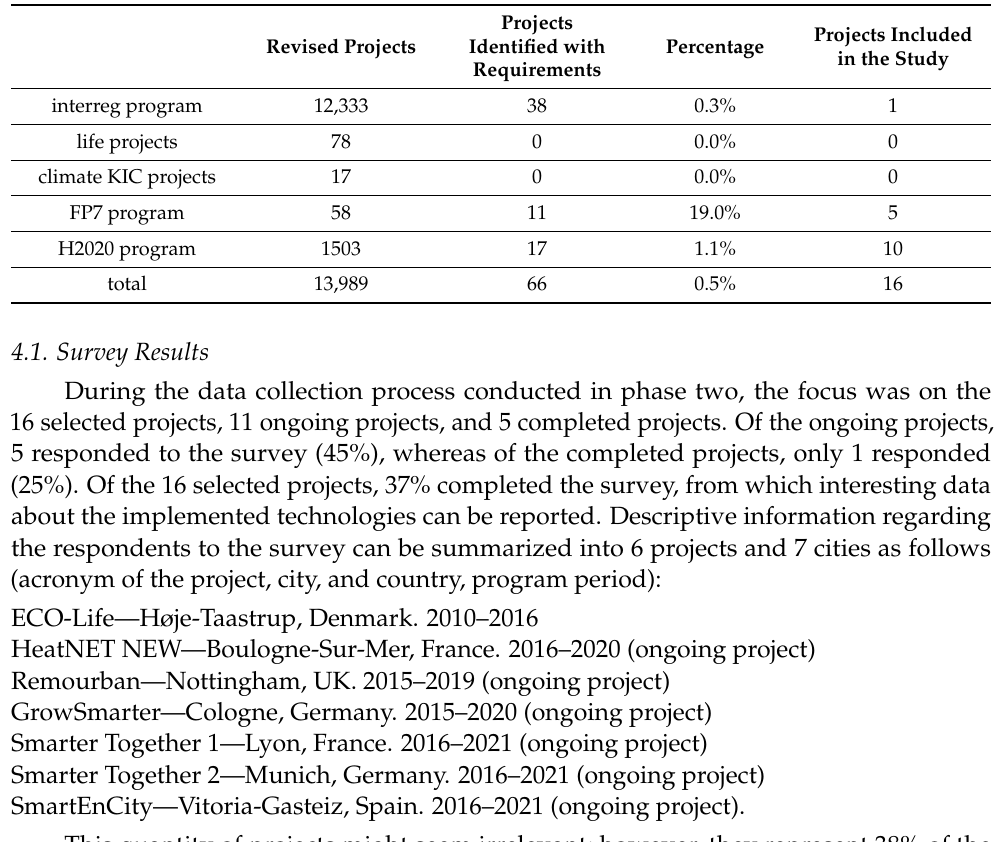
Table 5. Data from the research on European-funded